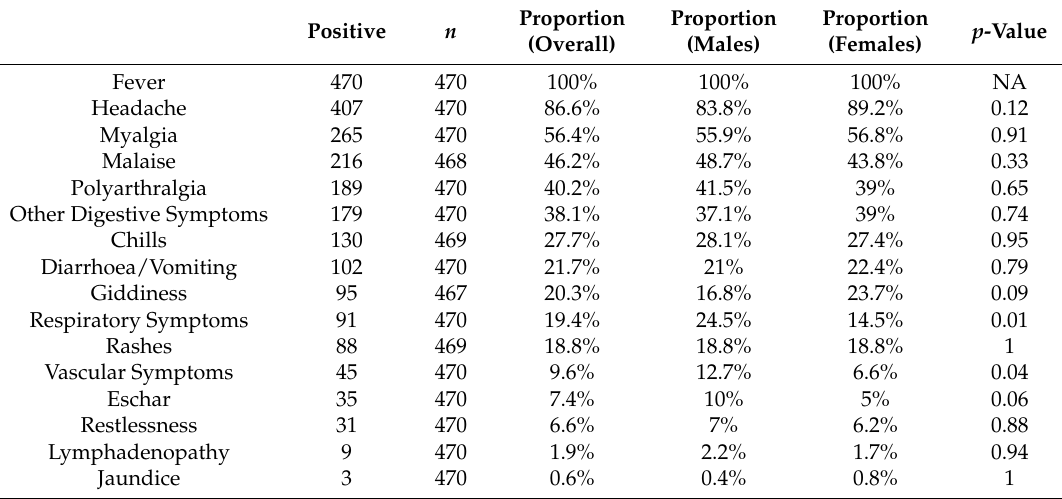
Table 1. Comparison of the clinical manifestations of 470 clinically suspected ST cases that tested